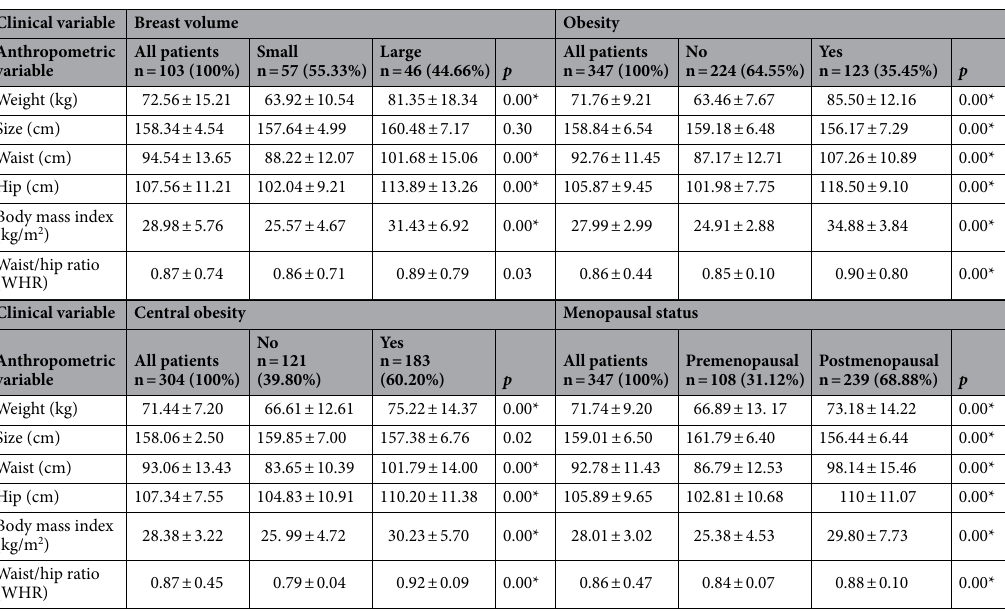
Table 2. Anthropometric characteristics of the patients with breast cancer according to their breast volume (small vs. large), BMI (obesity vs. non-obesity), central obesity (WHR < 0.85 vs. WHR ≥ 0.85) and hormonal status (premenopausal vs. postmenopausal). n = number of cases assessed for each variable. Data expressed as means ± standard deviation. * p <